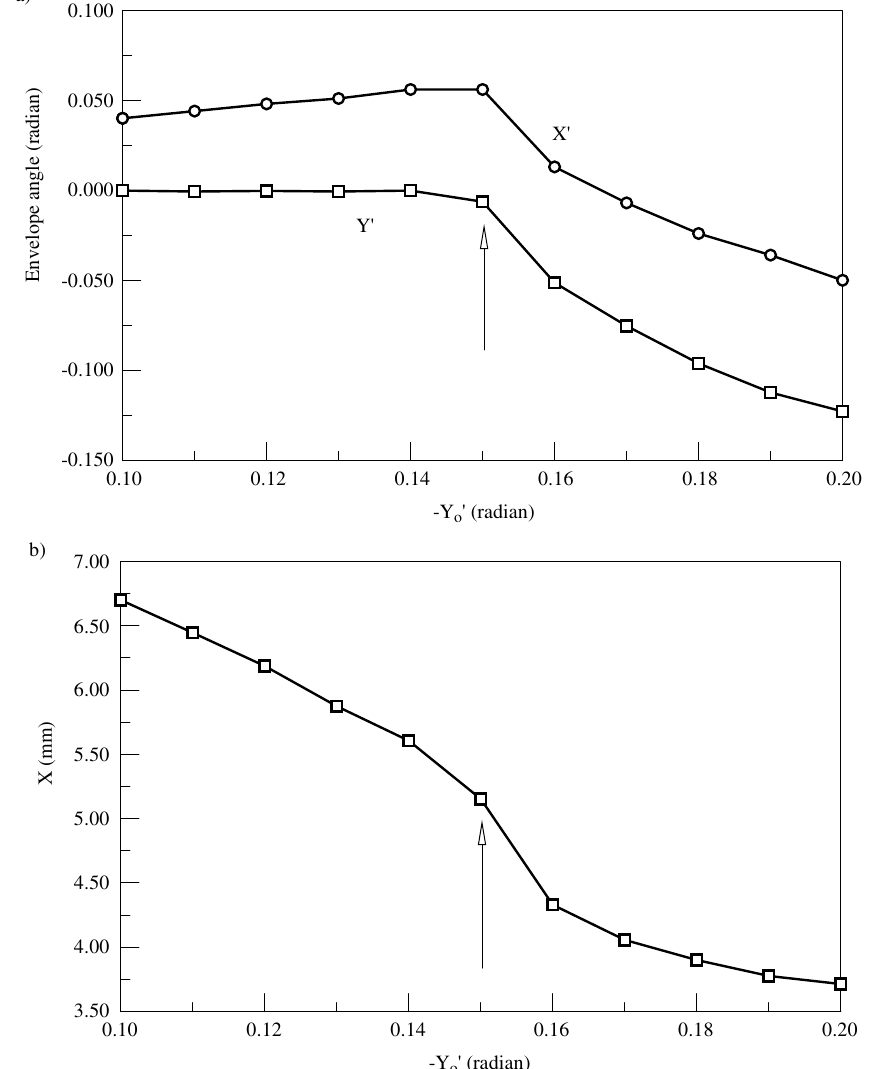
FIG. 3. Transformation by an anisotropic thin lens, solutions of the KVequations. Variations with initial vertical envelope angle (cid:1) 5 = 3 . Arrows show the optimal focus condition. (a) Envelope angles X 0 and Y 0 at the point of minimum vertical =f Y 0 for f x y 0 thickness. (b) Horizontal half-width X at the point of minimum vertical thickness.